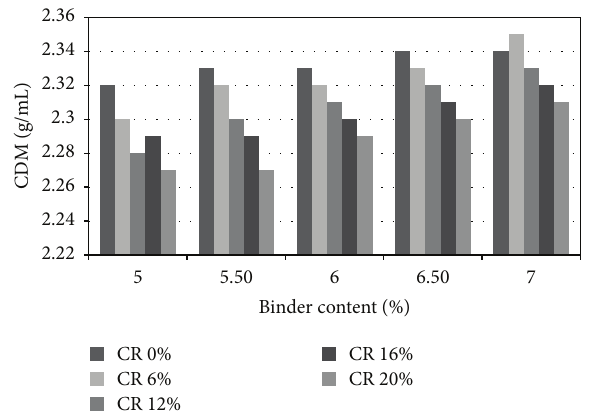
Figure 5: CDM results versus binder content.